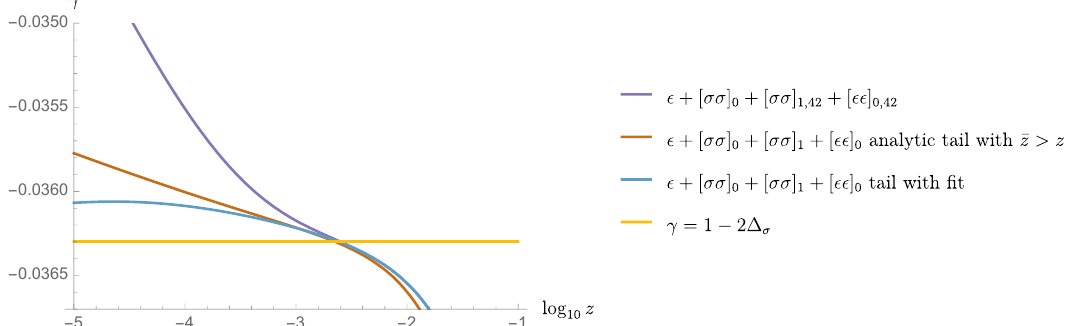
Figure 6 . Magnified version of figure 3, showing the importance of resumming large-spin tails to extract a z -independent stress-tensor twist. The difference between the two tails which is of order 10 − 4 and is a result of the difference between blue and orange curves in figure 5, gives an estimate of the error for the tail contribution).